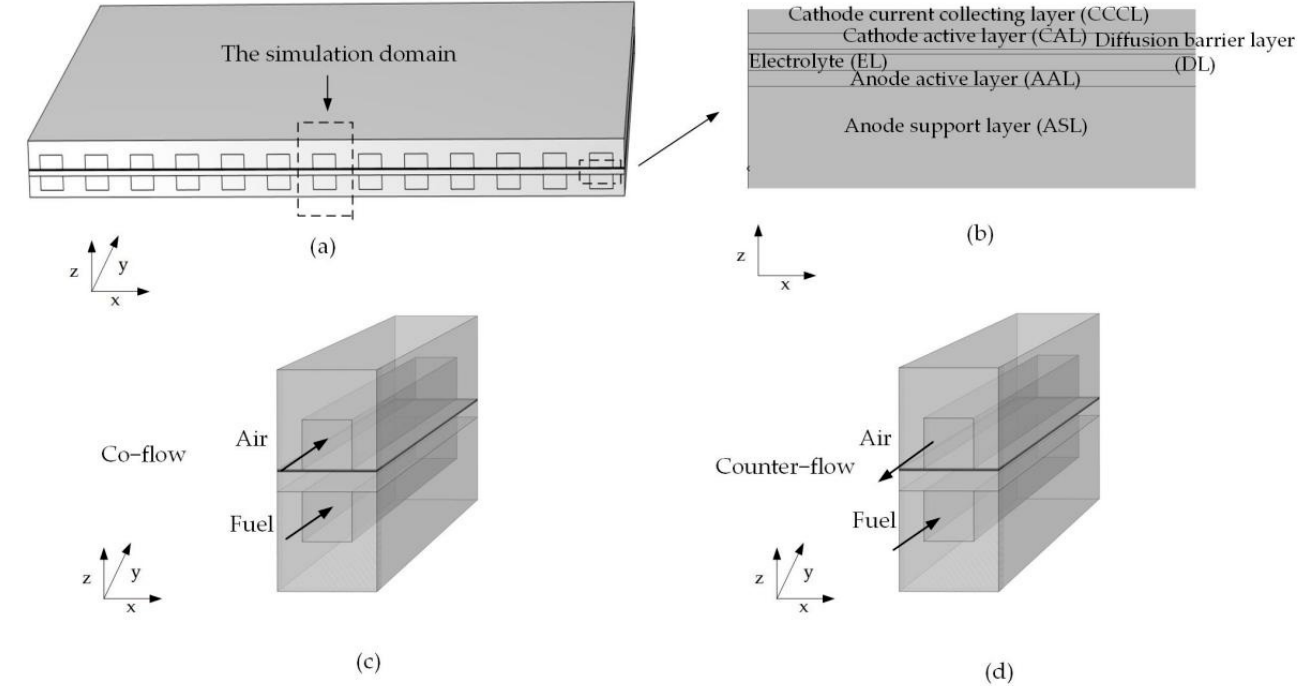
Figure 1. The schematic illustration for ( a ) the configuration of a planar anode-supported SOFC and metallic interconnects, ( b ) the PEN, ( c ) a co-flow arrangement, and ( d ) a counter-flow arrangement. Table 5. Properties for different components of the cell Table 4. Geometrical parameters of simulation domain.